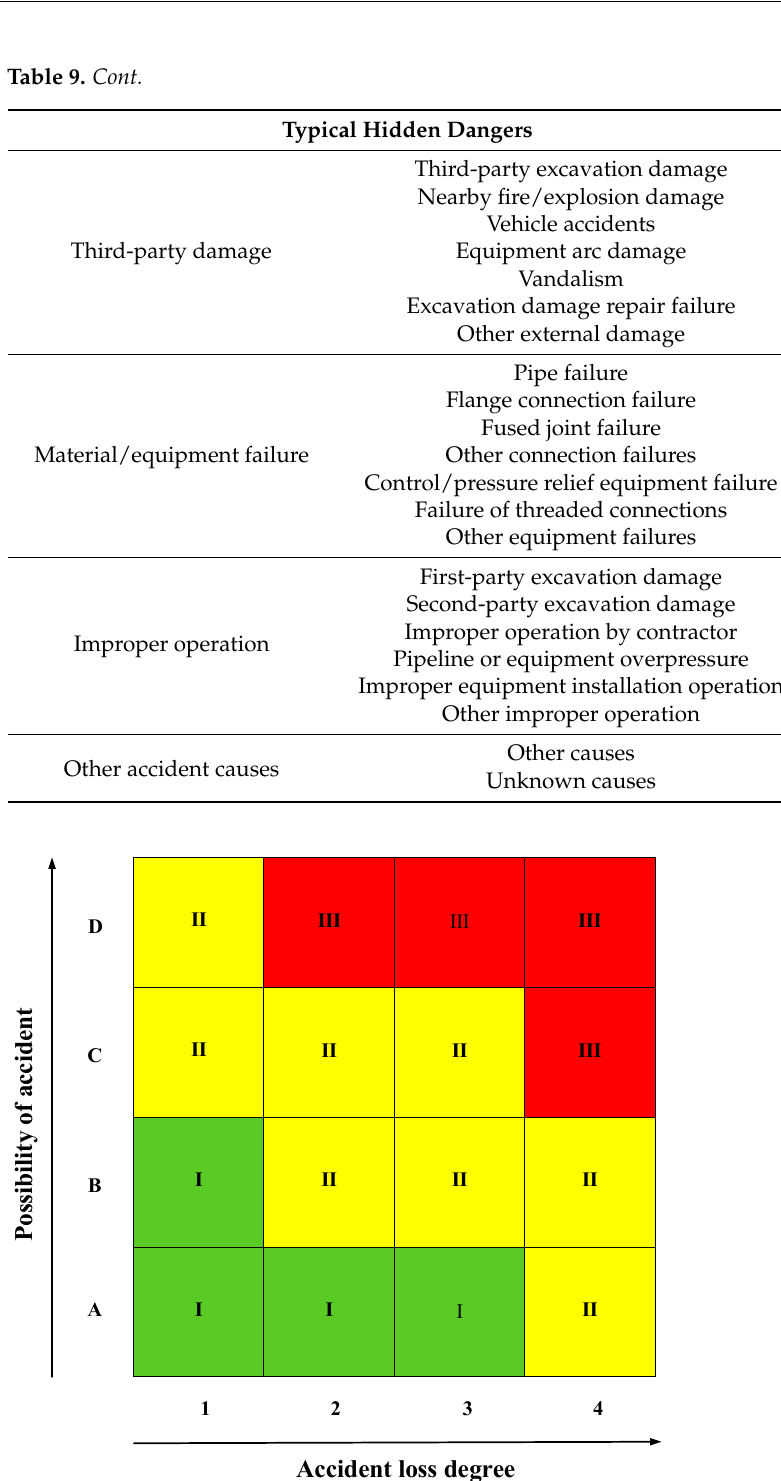
Figure 3. Risk matrix of hidden danger classification.